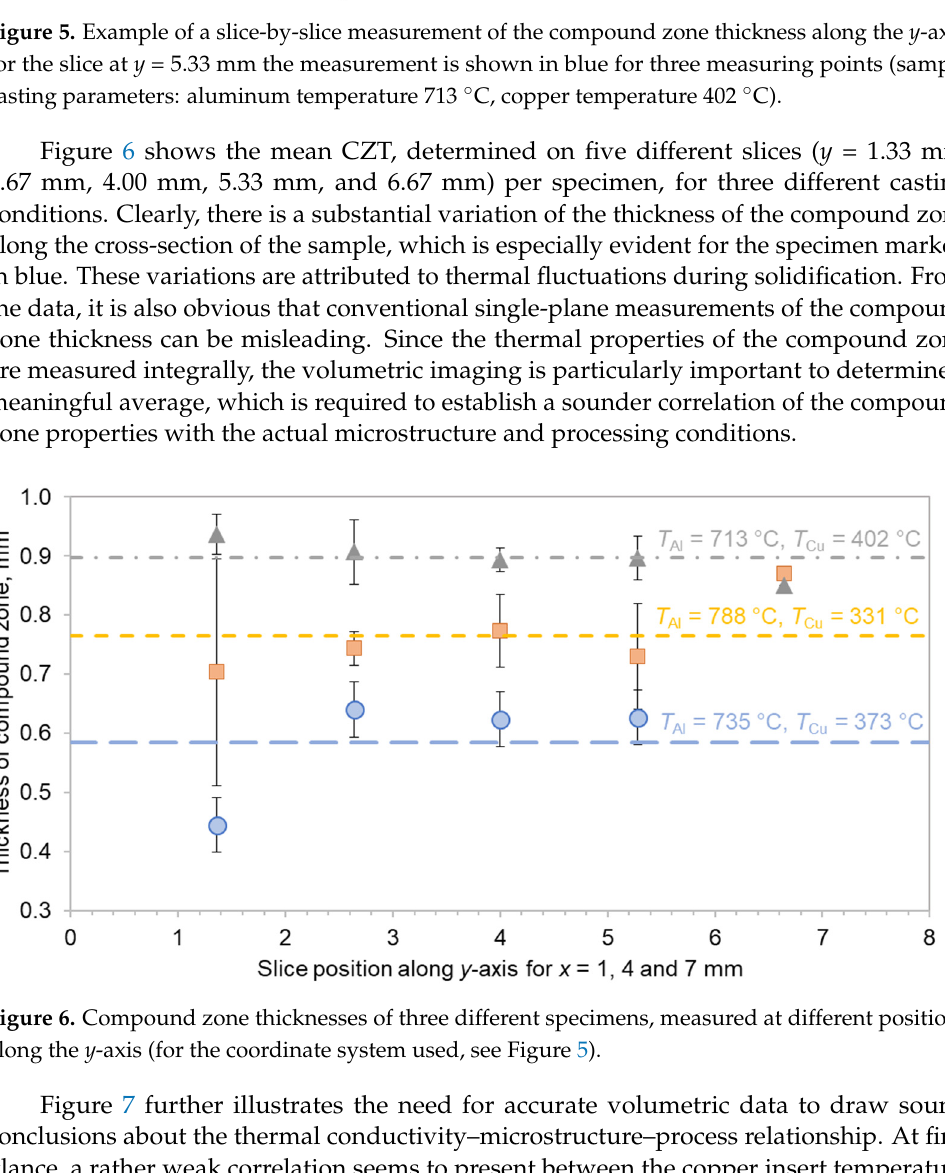
Figure 5. Example of a slice-by-slice measurement of the compound zone thickness along the y -axis, for the slice at y = 5.33 mm the measurement is shown in blue for three measuring points (sample casting parameters: aluminum temperature 713 °C, copper temperature 402 °C).